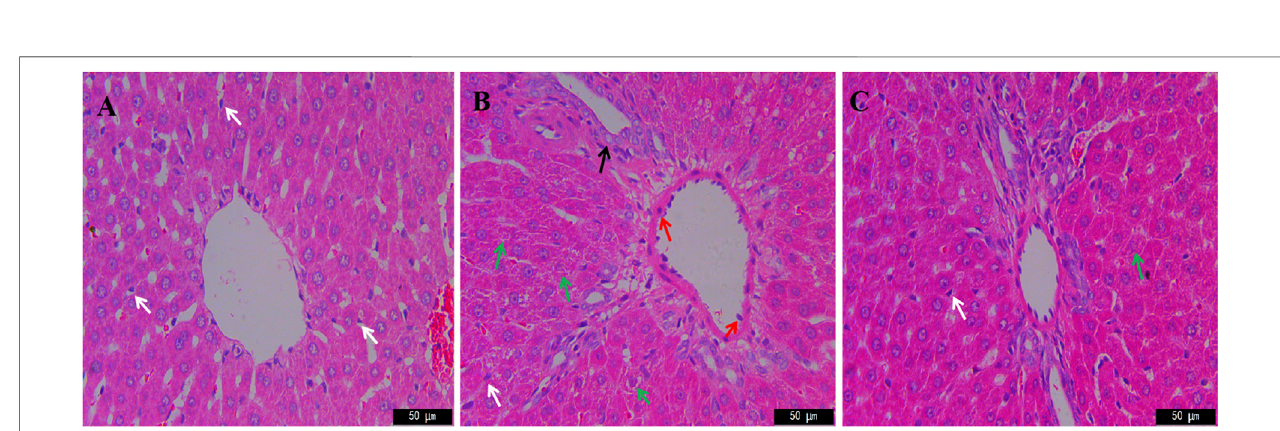
FIGURE2 | HE stainingin the therapeutic effectofJGCC against DHJS with microscope (×400). (A) Control; (B) Model; (C) JGCC. whitearrows: kupffer cells; red arrows: in fl ammatory cells; green arrows: hepatocyte necrosis; black arrows: swelling of vascular endothelial cells.